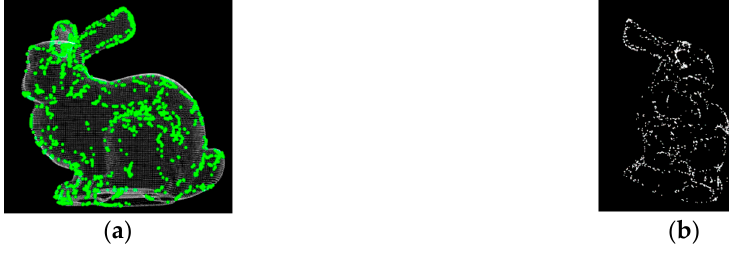
Figure 5. The boundary extracted from the bunny data set: ( a ) the point cloud and the boundary; ( b ) the boundary points from another viewport. ( b ) the boundary points from another